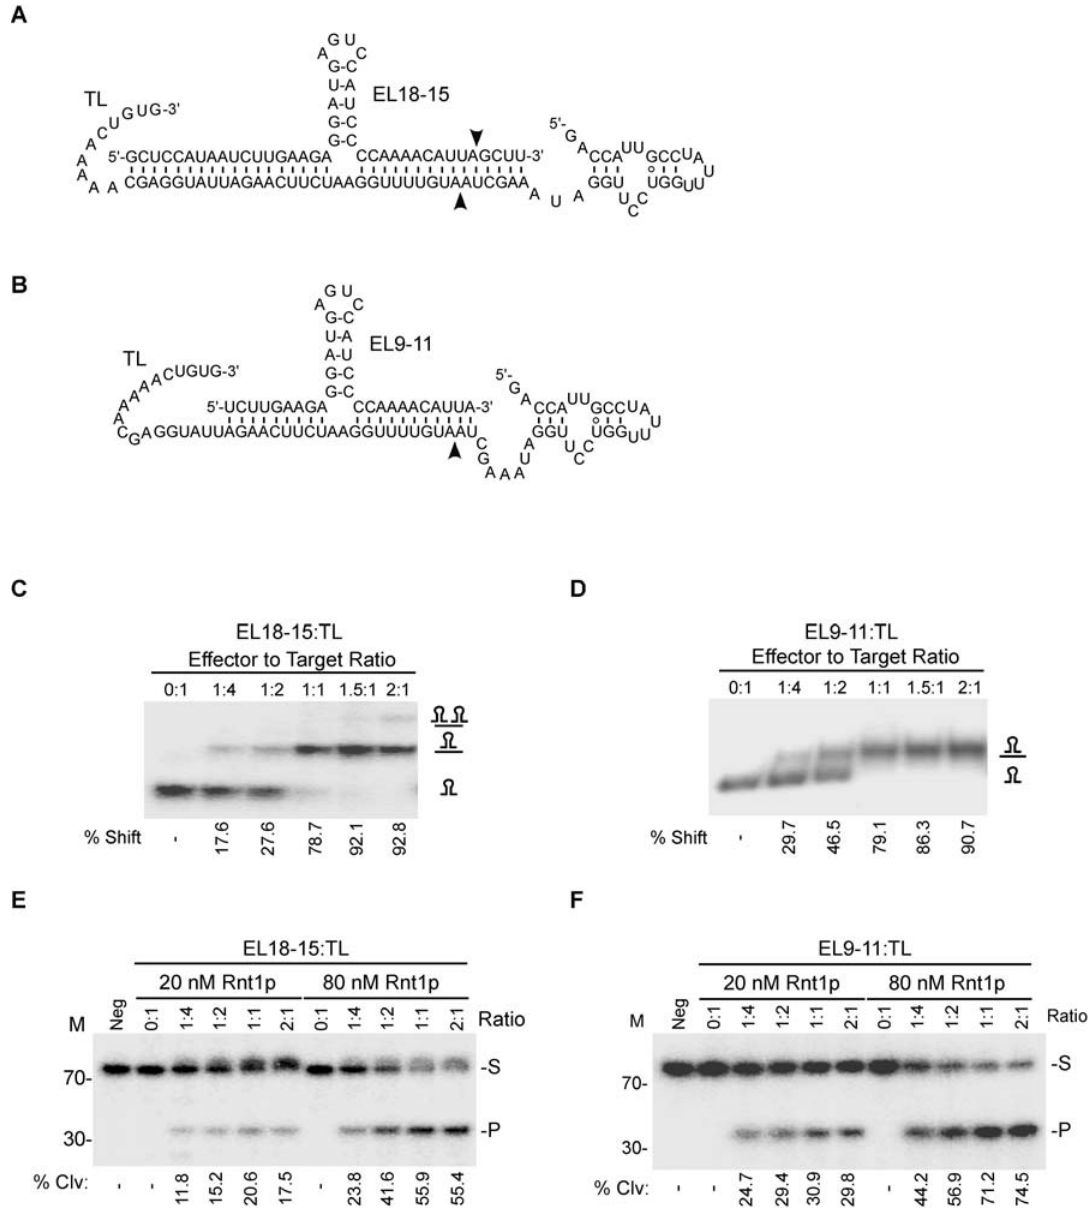
Figure 2. Rnt1p cleaves intermolecular RNA substrates. Illustrations of an RNA guide that could be cleaved by Rnt1p (EL18-15) (A) or a guide that cannot be cleaved by Rnt1p (EL9-11) (B) when in complex with the target RNA (TL). The arrowheads indicate the positions of the observed cleavage sites within the guide and target sequences. (C) and (D) illustrate the gel shift assay used to monitor the interaction of EL18-15 and EL9-11 with the target sequence (TL). The reaction products were loaded on a 12% non-denaturing PAGE. The complex formation was quantified using the Instant Imager and the average percent shift (%) obtained from two independent experiments is indicated below each gel. The complexes are indicated on the right. RNA cleavage was assayed using EL18-15 (E) or EL9-11 (F). The RNA was incubated with different ratios of 5 9 -end labeled target (TL) and two different Rnt1p concentrations (20 and 80 nM) for 20 minutes. The cleavage products were analyzed by 20% denaturing PAGE and the bands were quantified using Instant Imager. Average percent (%) cleavage of three independent experiments is indicated below each gel. The RNA marker is displayed on the left. The positions of the substrate (S) and product (P) are showed on the right.